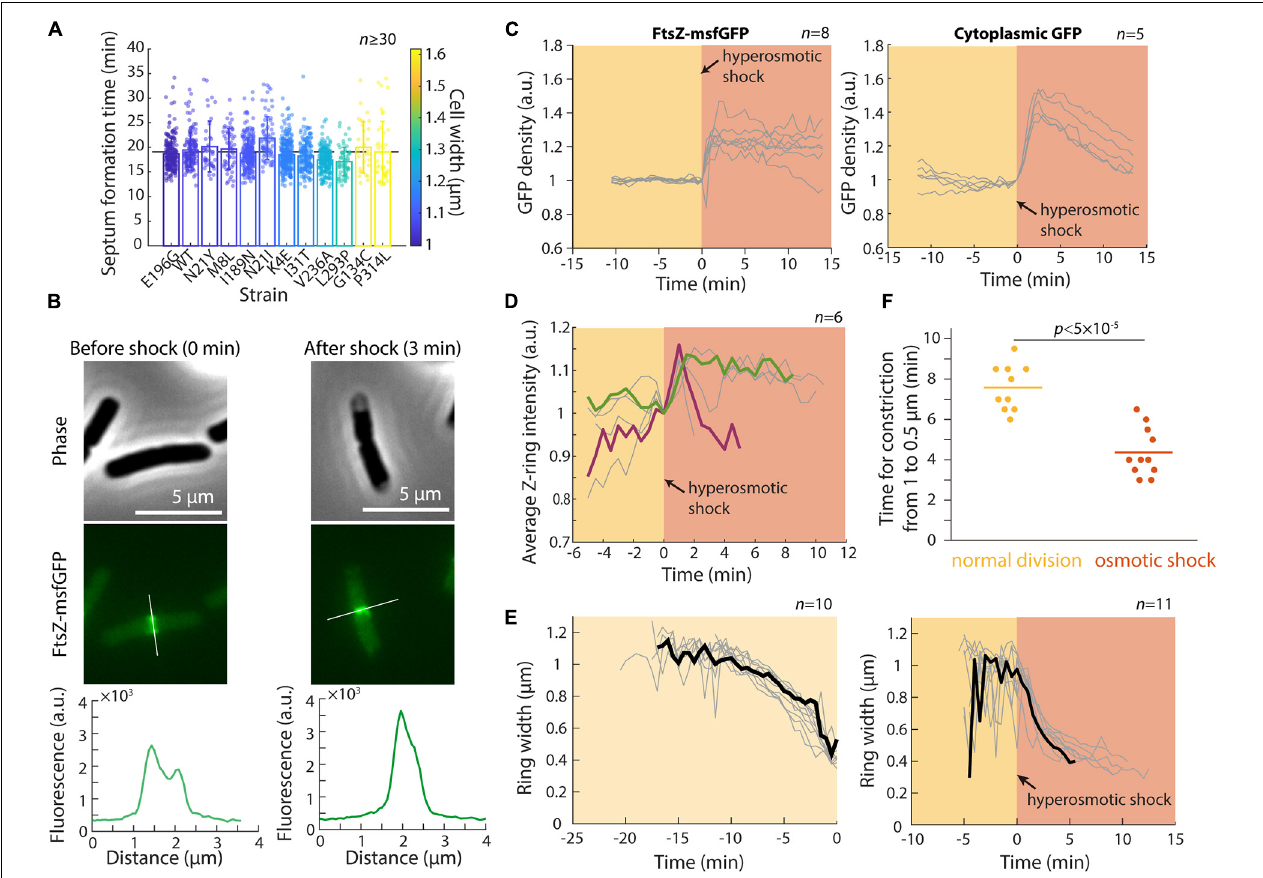
FIGURE 4 | Hyperomostic shock leads to increased FtsZ concentration and ring intensity and faster constriction. (A) Septum formation time (see section “Materials and Methods”) for mreB mutants of various cell widths was approximately constant as a function of mean cell width. (B) Phase-constrast (top) and epifluorescence (middle) images of E. coli cells expressing FtsZ-msfGFP, before (left) and 3 min after (right) a hyperosmotic shock. Fluorescence profiles along the cell contour show that Z-ring intensity increased immediately after the shock (bottom). (C) The concentration of FtsZ-msfGFP (left) and cytoplasmic GFP (right) increased directly after the hyperosmotic shock, consistent with the decrease in cell volume ( Figure 1B ). (D) Z-ring intensity increased after the shock. Shown are 6 representative cells; the cell colored in green maintained high Z-ring intensity for 10 min after the shock, while Z-ring intensity in the maroon cell increased and then decreased for the ensuing 4 min leading up to the completion of cell division. (E) Z-rings constricted more rapidly after hyperosmotic shock (right) than during normal growth (left). The black curves are representative cells in each category. (F) The time required for Z-ring constriction was substantially shorter after hyperosmotic